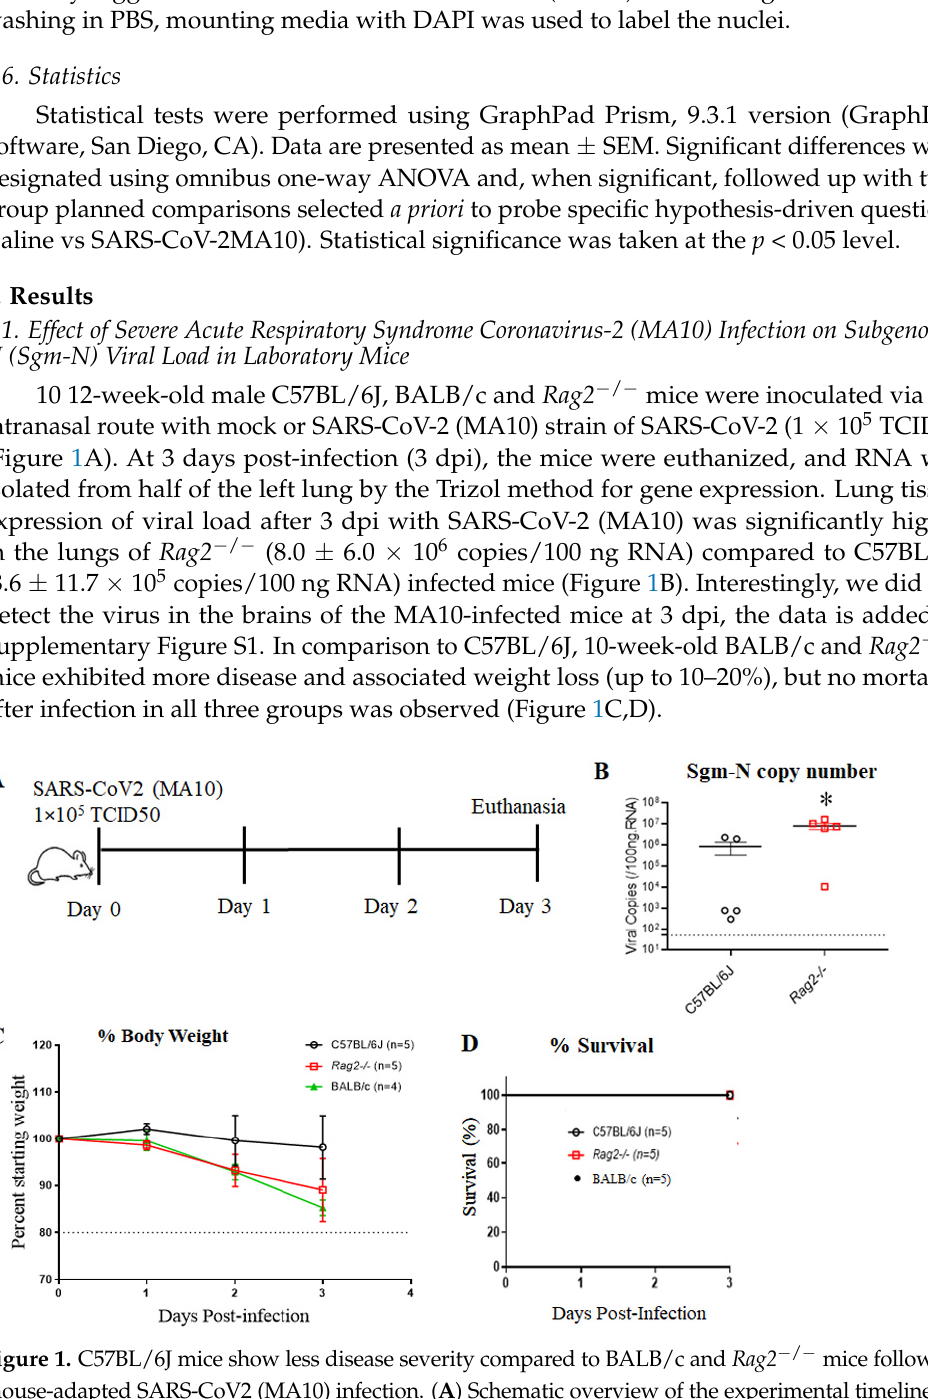
Figure 1. C57BL/6J mice show less disease severity compared to BALB/c and Rag2 − / − mice following mouse-adapted SARS-CoV2 (MA10) infection. ( A ) Schematic overview of the experimental timeline for 10 ‐ week ‐ old male C57BL/6, BALB/c, and Rag2 − / − mice. Animals were inoculated via the intranasal route with mock (PBS) or MA10 strain of SARS ‐ CoV ‐ 2 (1 × 10 5 TCID 50 ). Upon 3 days post ‐ infection (3 dpi), mice were euthanized, and RNA isolated from the lung samples by the Trizol method was processed for gene expression. ( B ) Subgenomic ‐ N viral copies and ( C ) Percent starting weight loss in SARS ‐ CoV ‐ 2 (MA10) ‐ infected C57BL/6 and SARS ‐ CoV ‐ 2 (MA10) infected Rag2 − / − mice and BALB/c ( D ) Survival rate. Data were analyzed using 2 ‐ factor ANOVA followed by Sidak’s multiple comparisons if more than two groups. The Mann ‐ Whitney U test is used to compare the difference in N viral copies between C57Bl/6J and Rag2 − / − . Error bars represent mean+/ − SEM, * p < 0.05, n = 4–5/group.